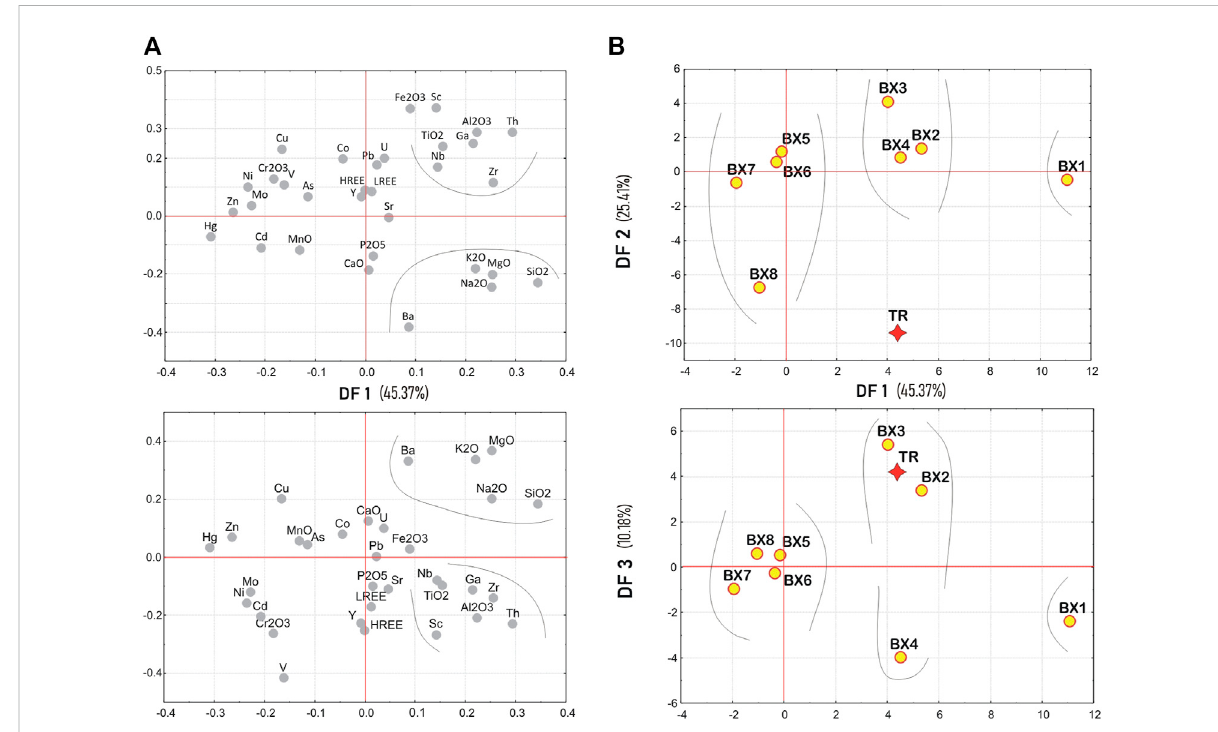
FIGURE 6 Comparison between variables and groups in the discriminant function model (DFM) of the clr-transformed data: scatterplots of (A) variable loadings and (B) bauxite groups in the reduced discriminant space of the fi rst three discriminant functions (DF1 – DF2 and